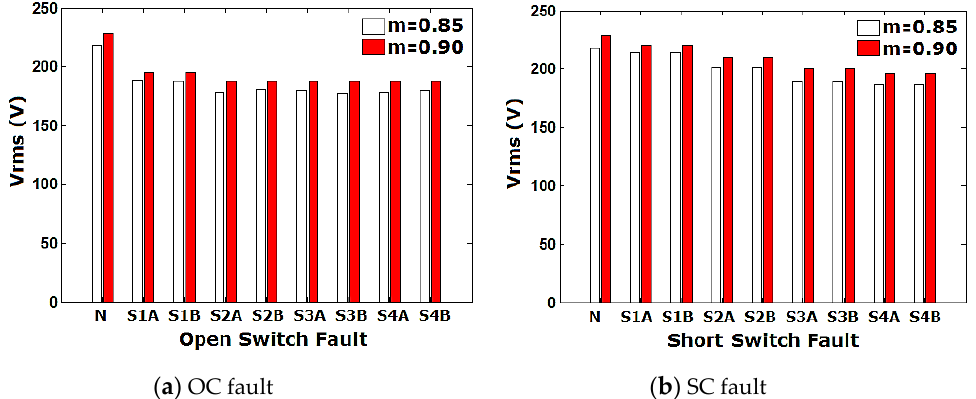
Figure 11. Output voltage waveforms attained at distinct modulation index values at various fault conditions.